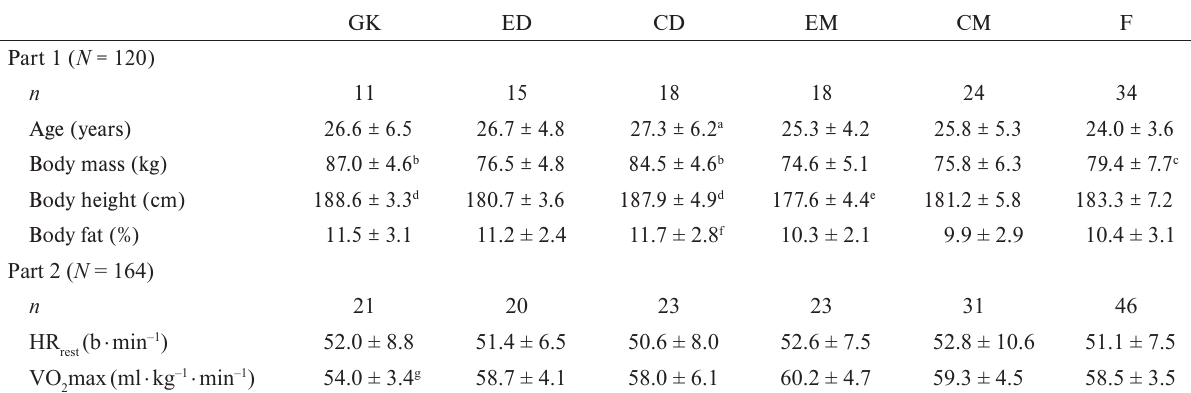
Anthropometric and cardiorespiratory values according to playing positions (mean ± SD) GK ED